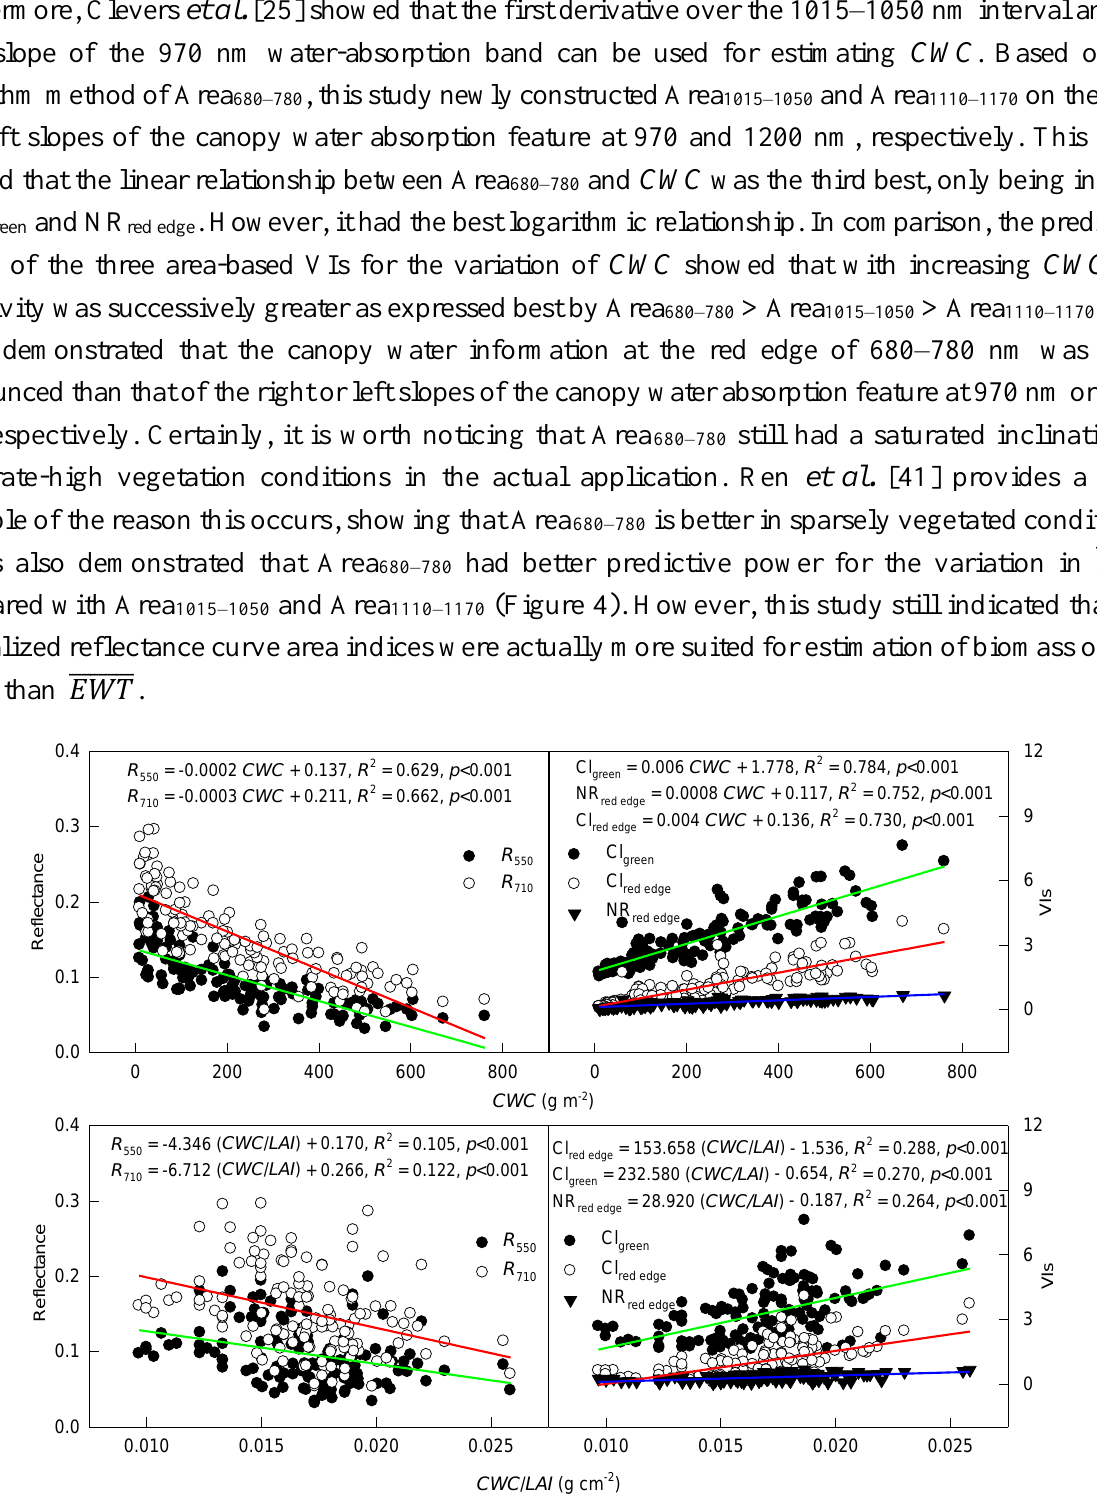
Figure 7. Relationships between CWC and 𝐸𝑊𝑇̅̅̅̅̅̅̅ ( CWC / LAI ) vs. reflectance ( R 550 and R 710 ) and CWC and 𝐸𝑊𝑇̅̅̅̅̅̅̅ ( CWC / LAI ) vs. VIs (CI green , CI red edge , and NR red edge ) for maize